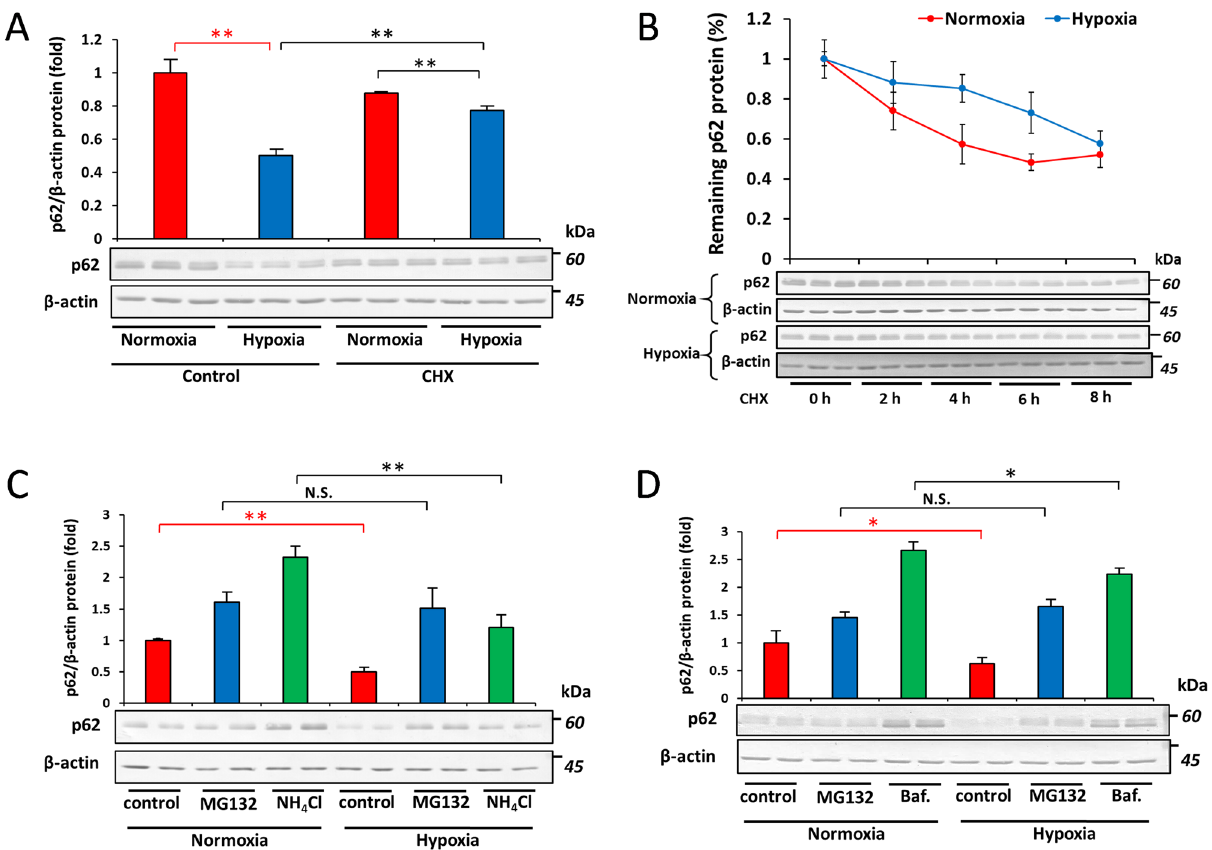
Figure 3. Involvement of the proteasome system in the degradation of p62 under hypoxia. ( A ) Hep3B cells were treated with vehicle (DMSO) or 10 μM cycloheximide and cultured under normoxia or hypoxia (O 2 = 1%) for 12 h. The protein abundance of p62 was then examined by immunoblotting. ( B ) Hep3B cells were treated with 10 μM cycloheximide and cultured under normoxia or hypoxia (O 2 = 1%) for the indicated period of time. p62 protein levels were then assessed by immunoblotting. ( C ) Hep3B cells were treated with vehicle (DMSO), 5 μM MG132, or 10 mM NH 4 Cl and cultured under normoxia or hypoxia (O 2 = 1%) for 12 h followed by immunoblotting for the measurement of p62 protein levels. ( D ) Hep3B cells were treated with vehicle (DMSO), 5 μM MG132, or 10 nM bafilomycin and cultured under normoxia or hypoxia (O 2 = 1%) for 12 h. p62 protein levels were quantified by immunoblotting. Data are presented as the mean ± S.D. of triplicate experiments. N.S. not significant, * p < 0.05, ** p < 0.01 versus the indicated group, calculated with a one-way ANOVA with Tukey’s post-hoc